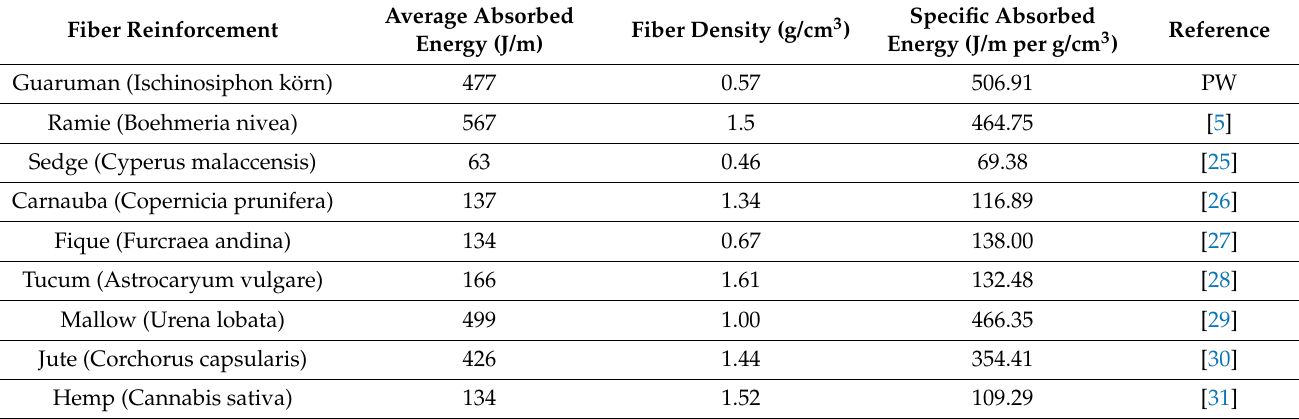
Table 4. Izod absorbed impact energy of 30 vol% natural fibers reinforcing epoxy composites with notched specimens. Fiber